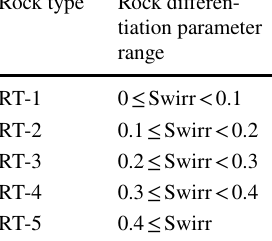
Table 1 Reservoir rock classes according to the water saturation